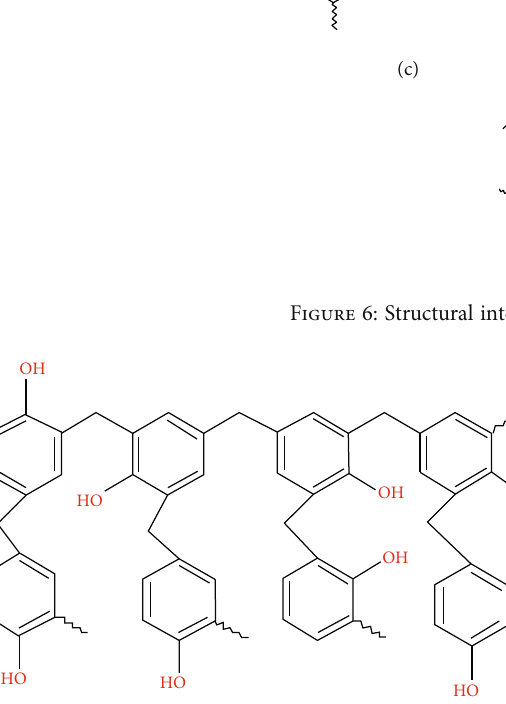
Figure 7: Novolac-type phenolic resin forms a network-like strengthening